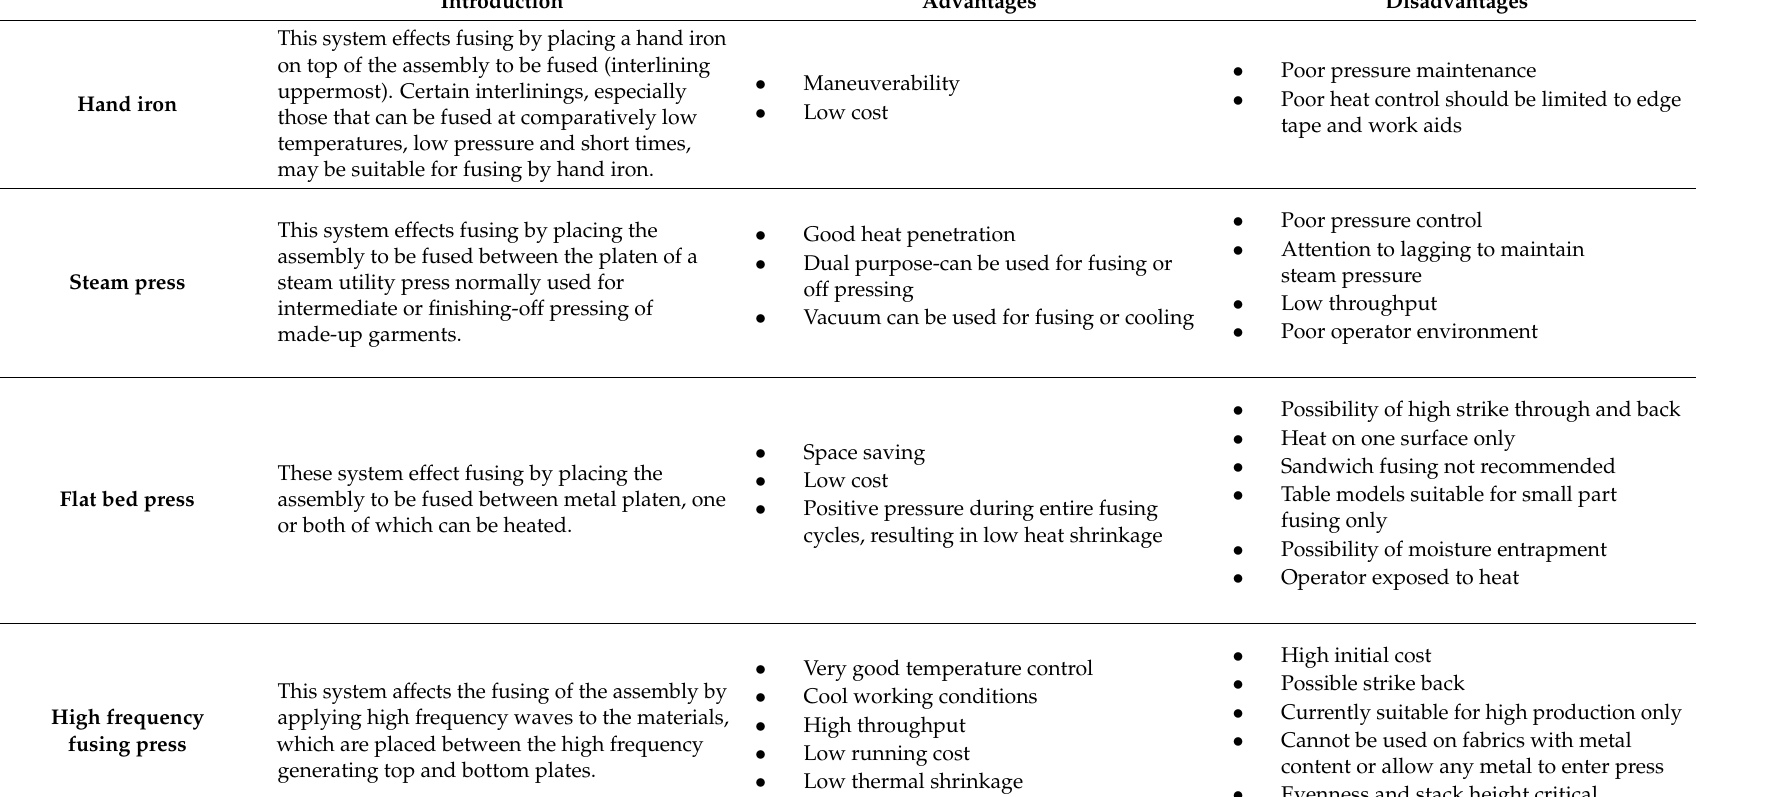
Table 4. Summary of advantages and disadvantages of fusing press